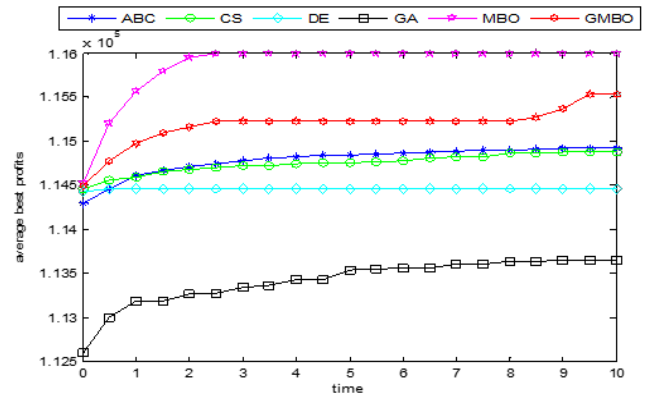
Figure 21. The convergence graph of six methods on KP9 in 10 seconds.